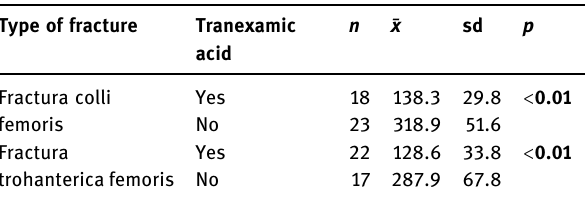
Table 2: Intraoperative blood loss by type of fracture and applica - tion of tranexamic acid ( TXA